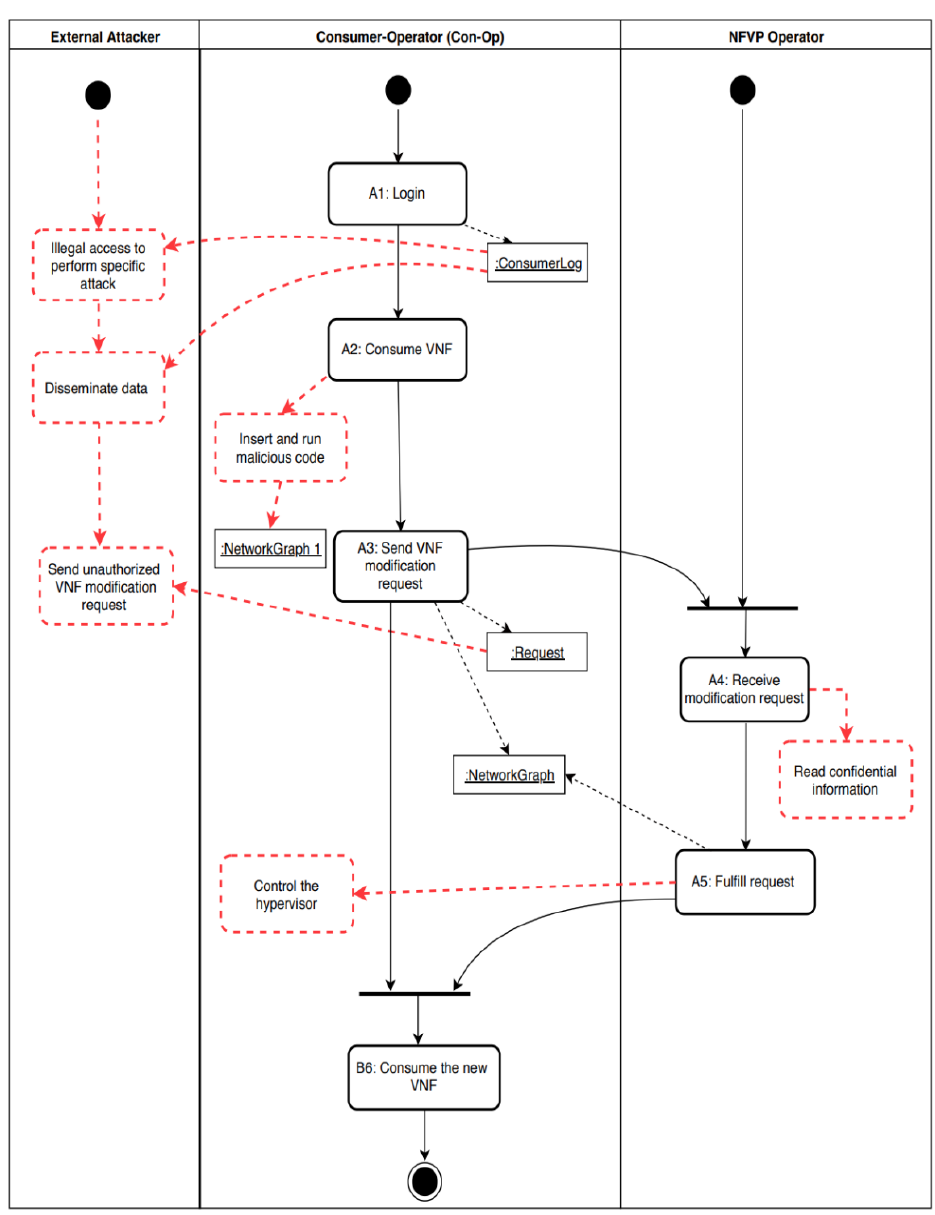
Figure 3. Activity diagram for UC13 “Request Modify VNF” and UC20 “Consume a Network”. Table 1. Misuse activities